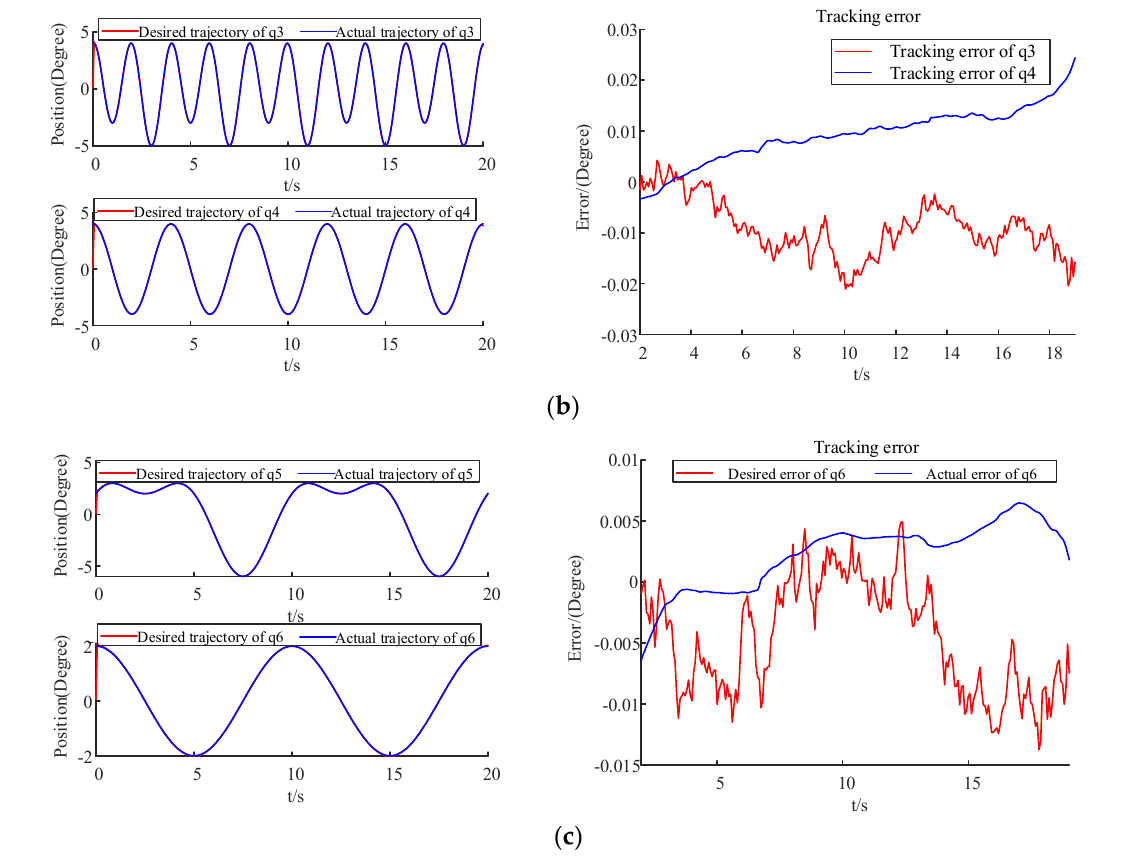
Figure 9. Tracking performance and errors for each joint of the 6DOF robot. ( a ) Tracking performance and tracking error of q1 and q2; ( b ) Tracking performance and tracking error of q3 and q4; ( c ) Tracking performance and tracking error of q5 and q6.